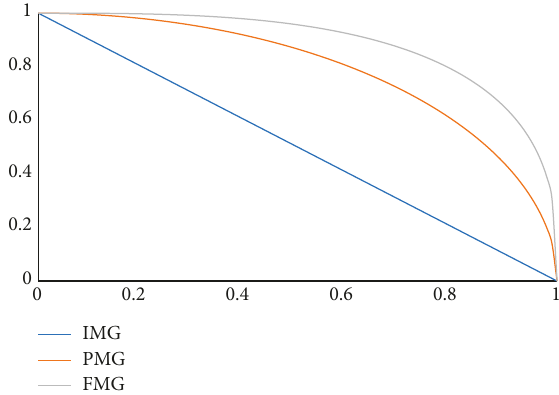
Figure 1: Comparison of space of FMGs, PMGs, and